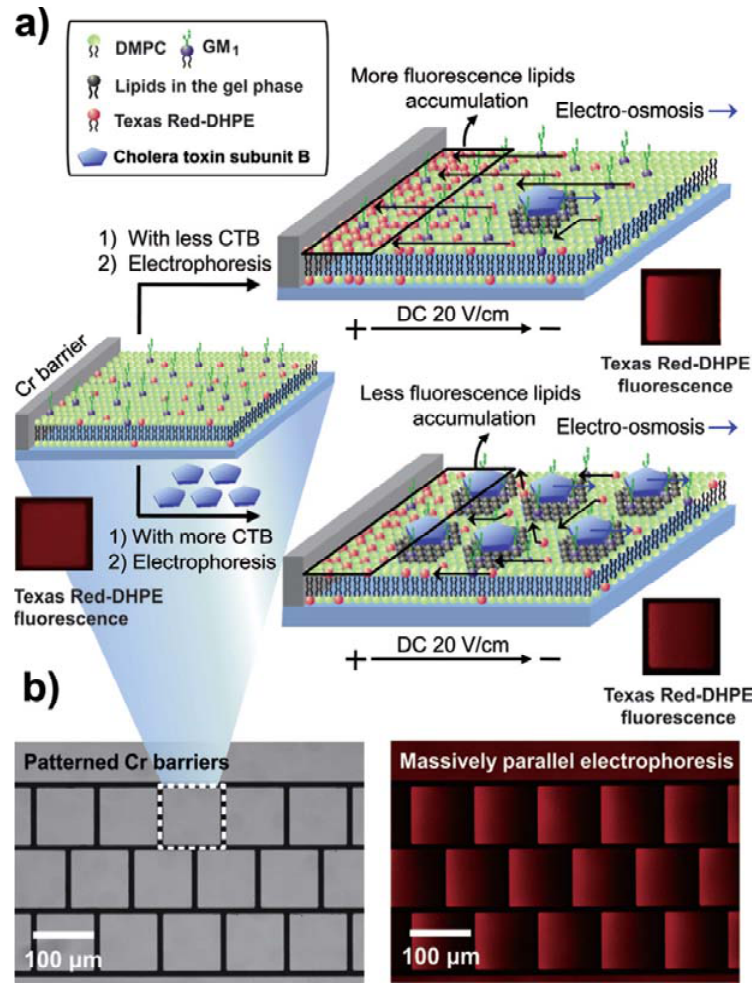
Figure 8. ( a ) Schematic illustration of an electrofluidic lipid membrane biosensor. Red insets are microscope images of the SLB. ( b ) Left: microscope image of multiple corrals patterned on a glass substrate. Right: electrophoresis of multiple SLB patterns. Reprinted with permission from Lee et al . Copyright (2012) John Wiley & Sons, Inc.